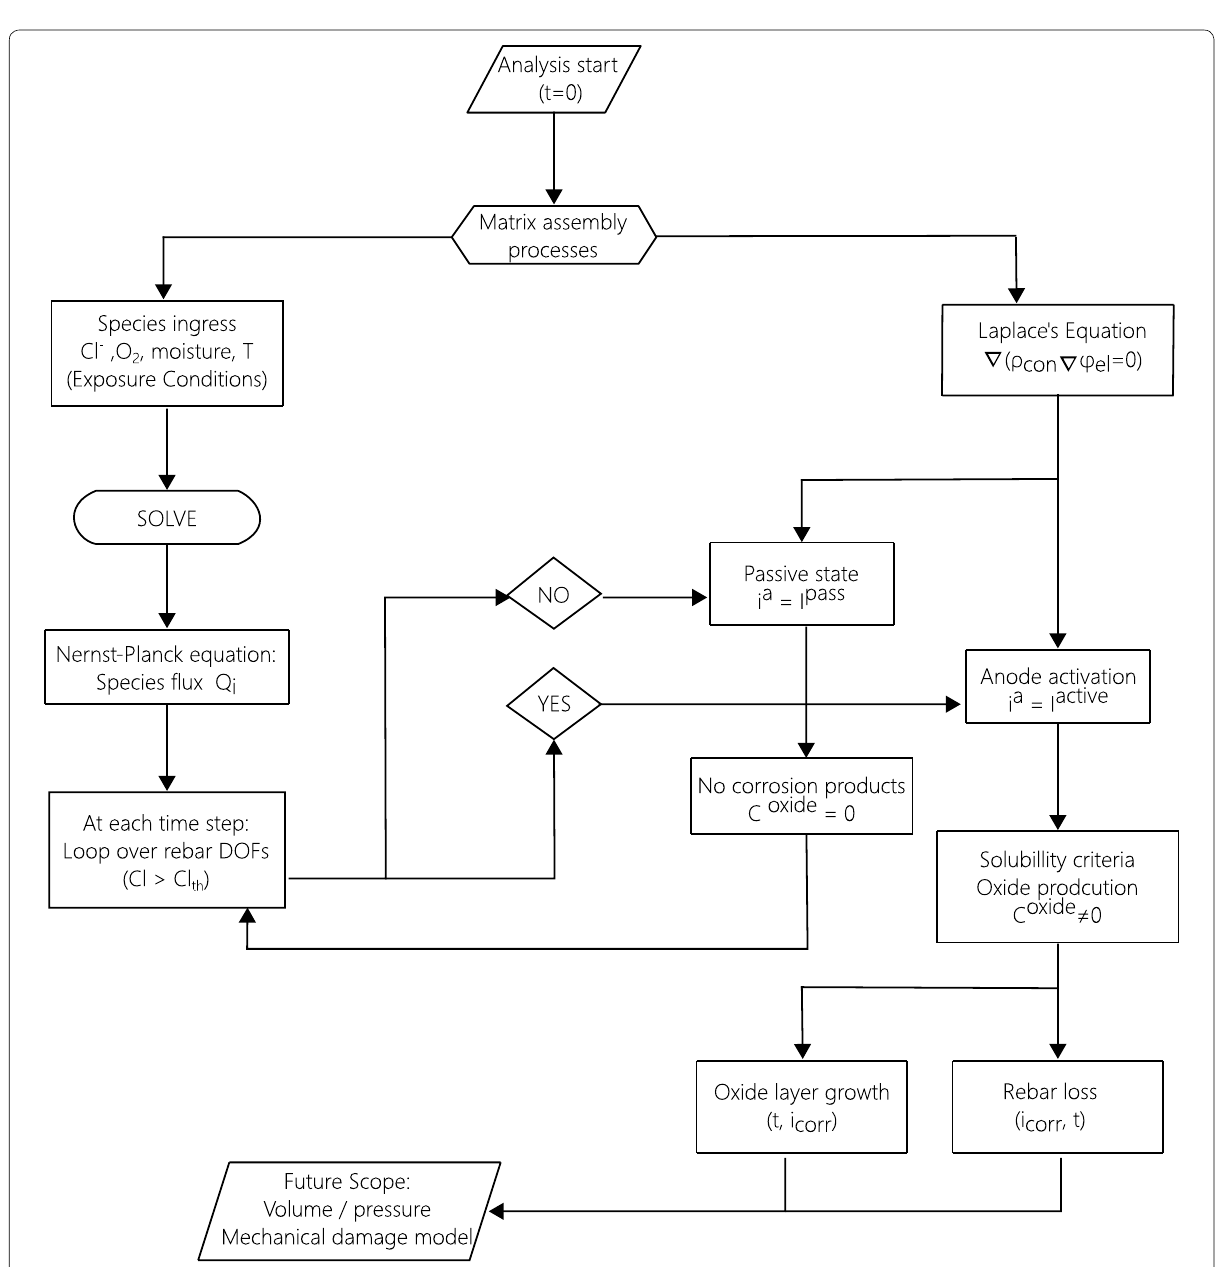
Fig. 2 Flow diagram representing the algorithm behind the numerical